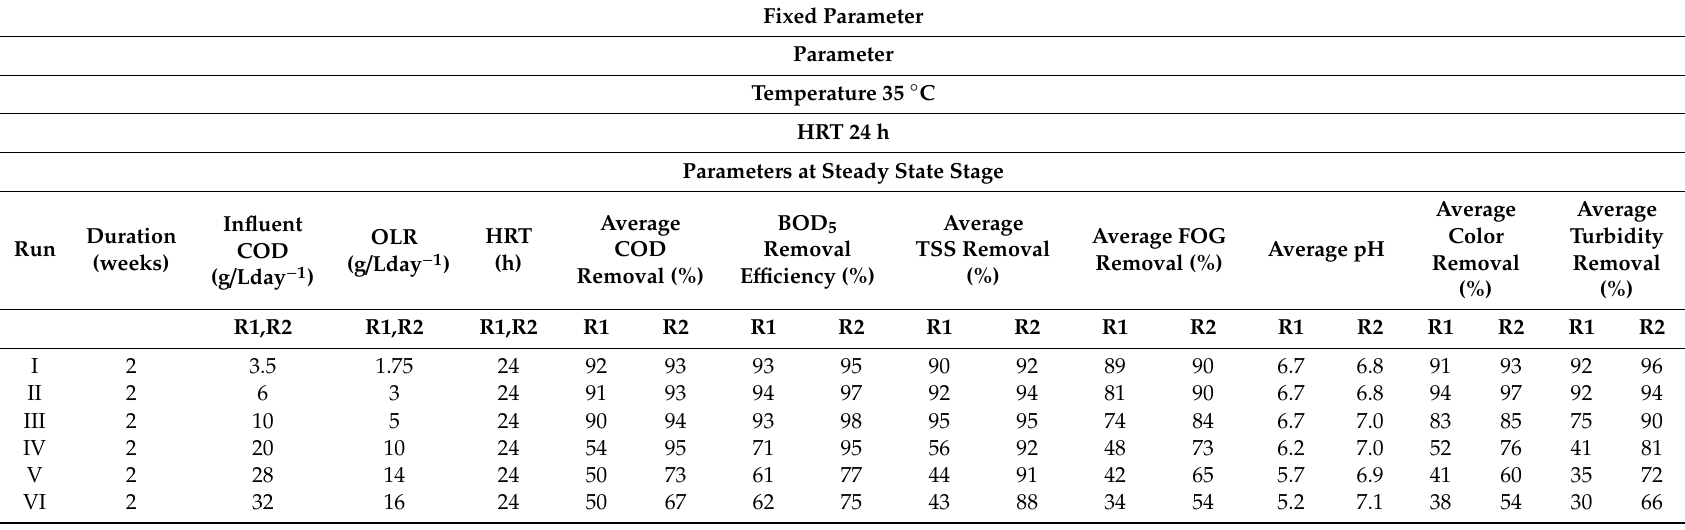
Table 3. Results of the average performance study of the conventional (R1) and modified (R2) UASB